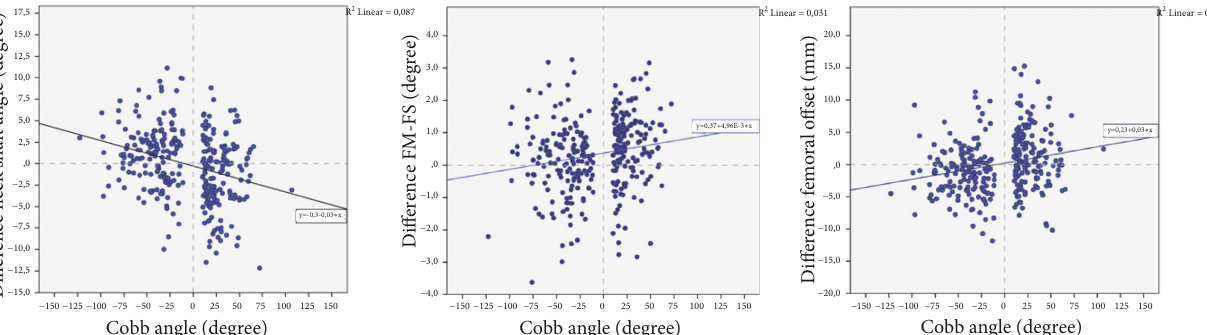
Figure 4: Side difference. Boxplot diagram presenting the correlation between the Cobb angle (positive values indicate a left main curve; negative values indicated right main curve) and the difference between the lower limb parameters (left side value-right side value).